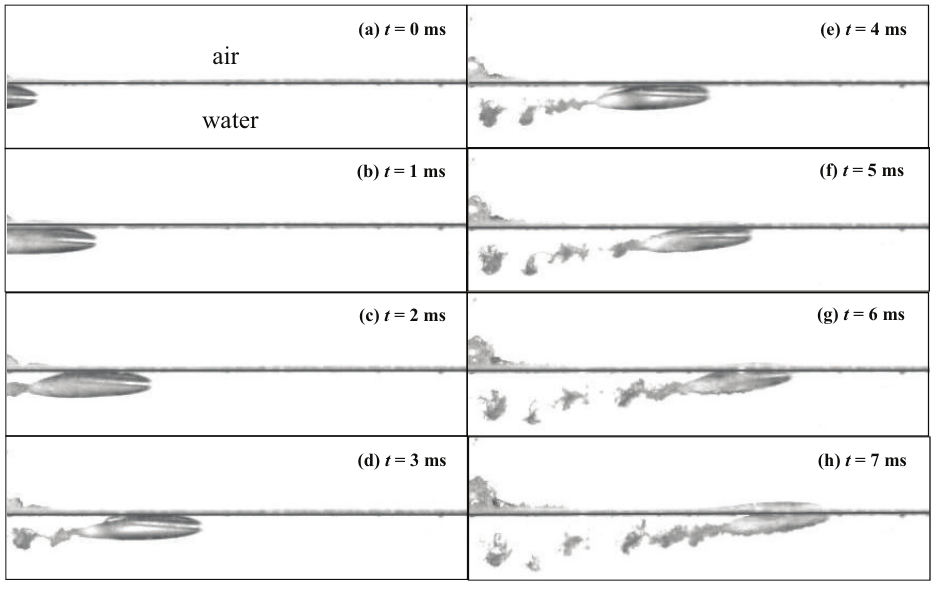
Figure 5. Supercavitation evolution of the projectile with hydrophilic coating at 3.33D water depth ( ∆ t = 1 ms, V 0 = 37.1